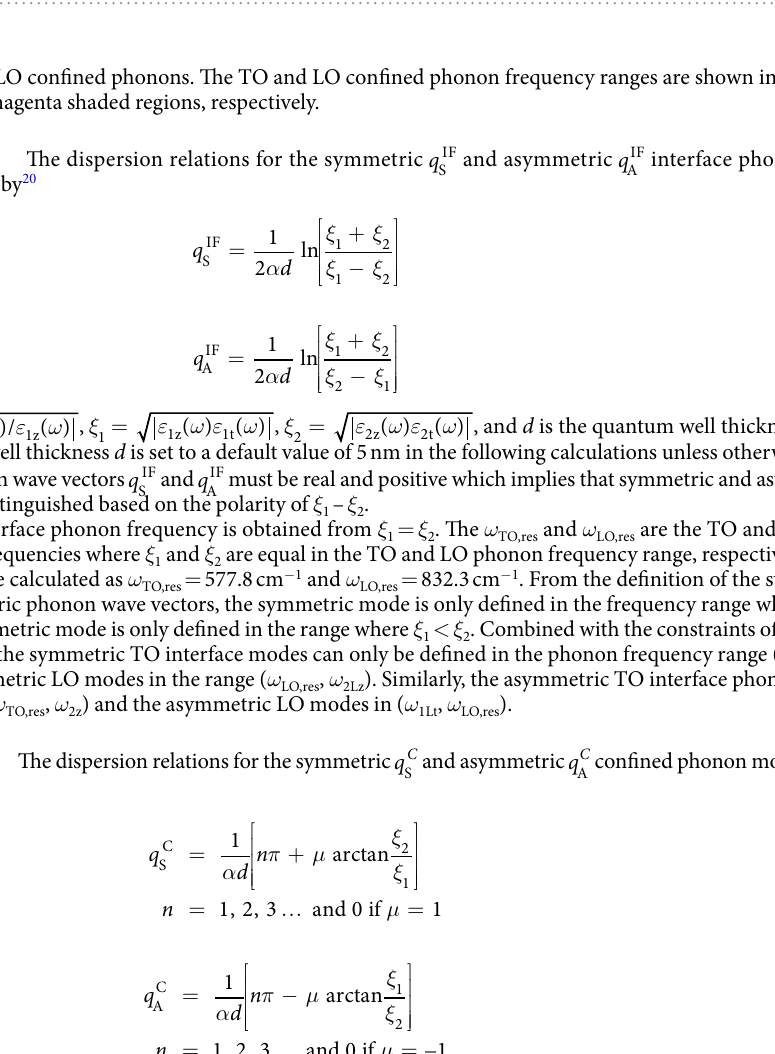
Figure 1. The dielectric constants as a function of phonon frequency are plotted. The characteristic frequencies of the dielectric functions which define the range of available interface (IF) and confined (C) mode phonon frequencies are indicated by vertical dashed lines. The region shaded in red ( ω 1t , ω 2z ) is where the interface phonons associated with the TO phonon modes of bulk GaN and AlN are defined. The region shaded in blue ( ω 1Lt, ω 2Lz ) is where the interface phonons associated with the LO phonon modes of bulk GaN and AlN are defined. The regions shaded in green ( ω 1z , ω 1t ) and magenta ( ω 1Lz , ω 1Lt ) are where the confined phonons are